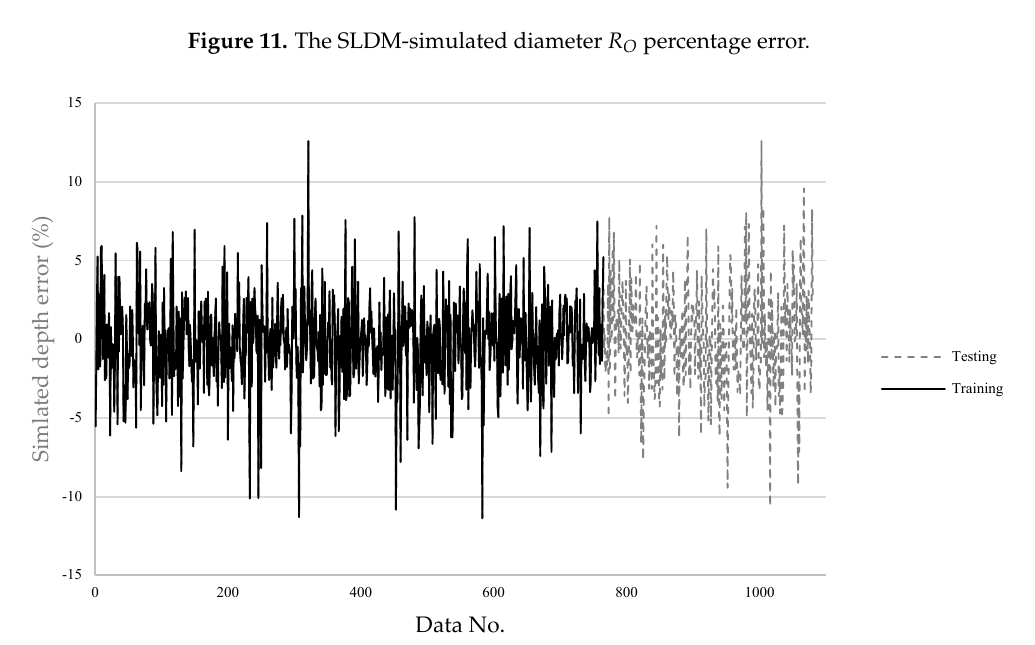
Data No. Figure 12. The SLDM-simulated depth D O percentage Figure 12. The SLDM-simulated depth D O percentage error. Figure 12. The SLDM-simulated depth D O percentage error.